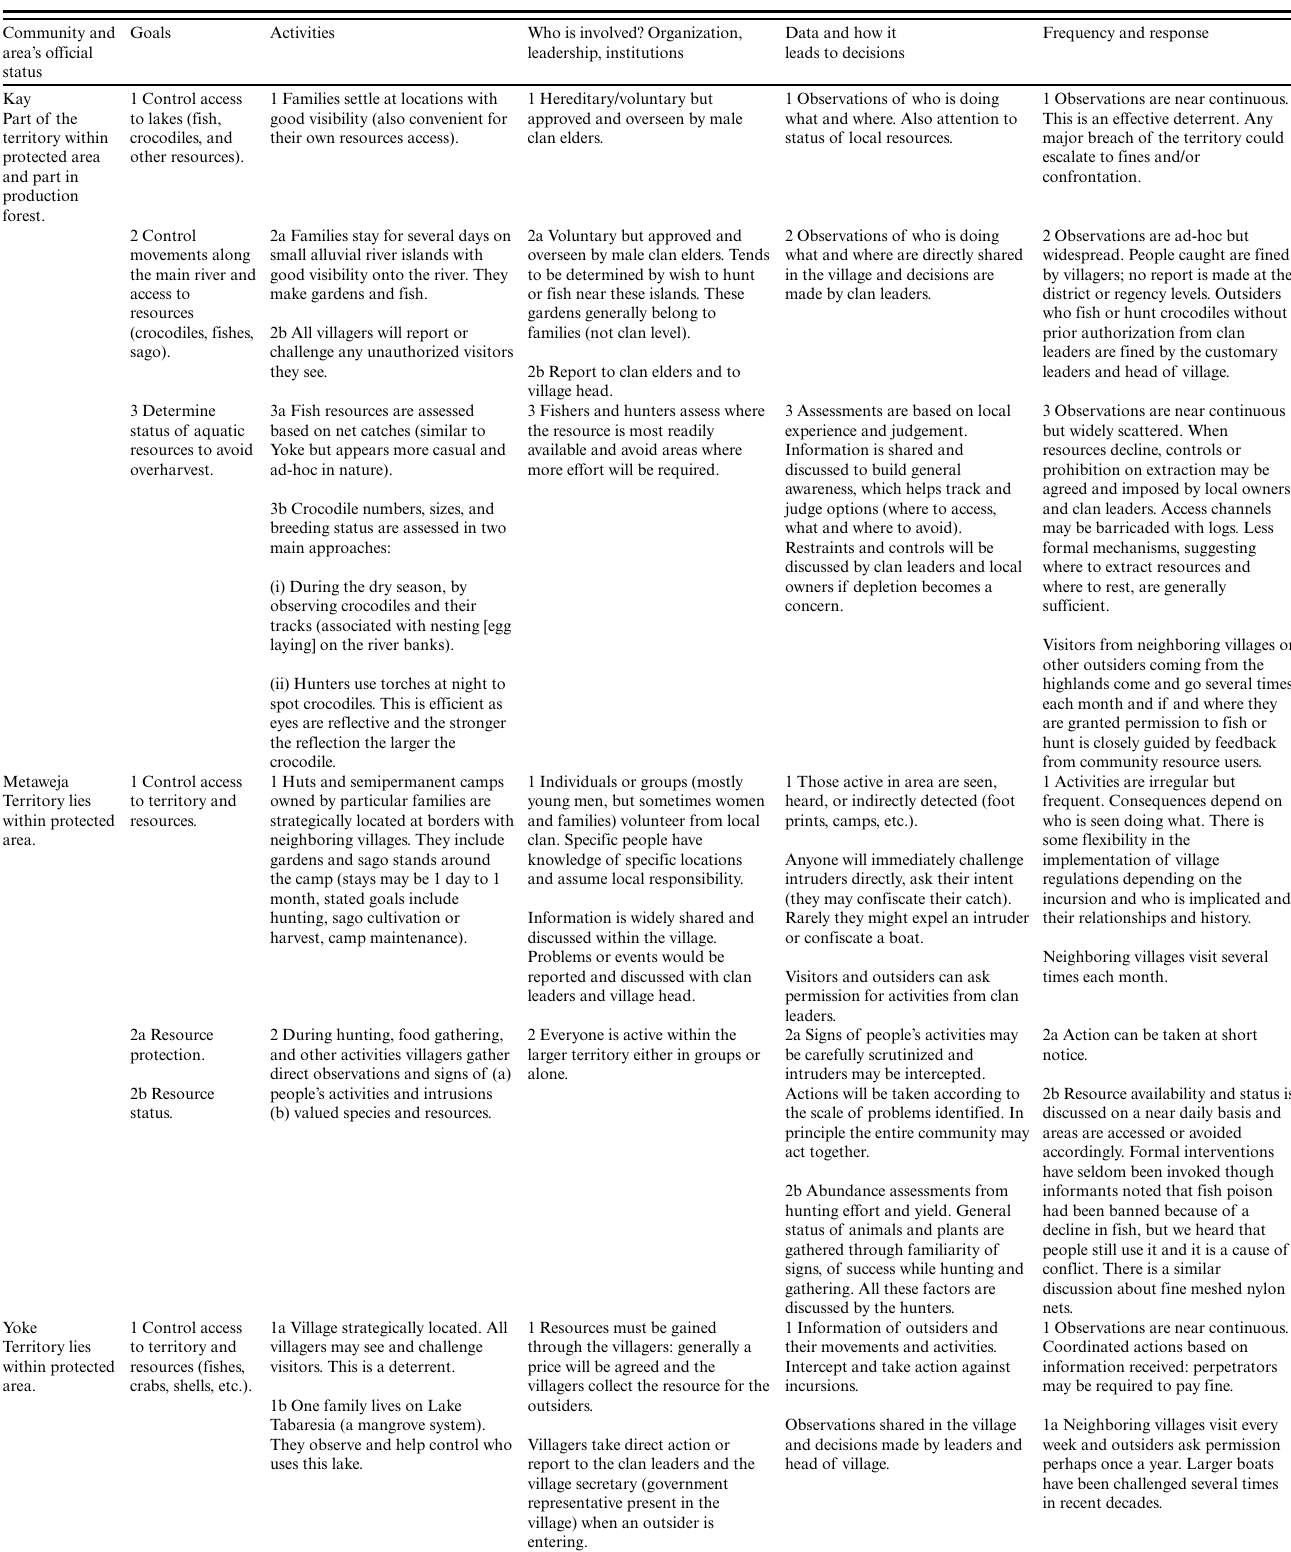
Table 2 . Local monitoring observed in the Mamberamo Watershed (Papua, Indonesia) by community, including goals, activities, and how monitoring is undertaken. In each village we identified distinct processes (numbers) that themselves may address more than one issue or be used in more than one way (numbers subdivided by